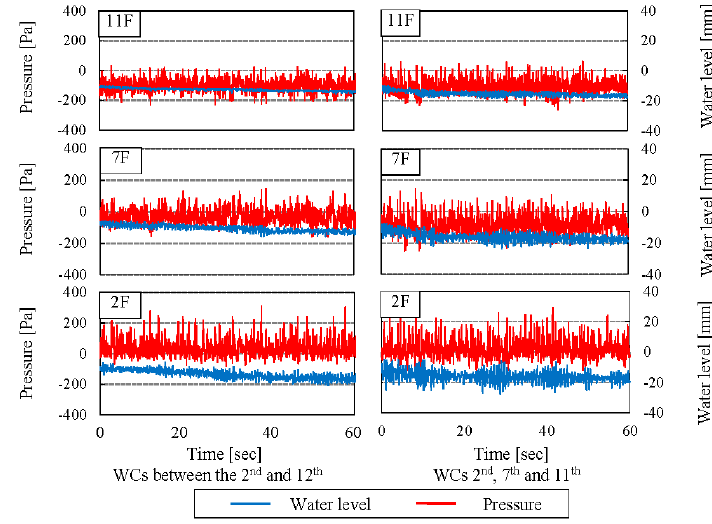
Figure 3. Examples of pressure fluctuation wave patterns and seal water fluctuation wave patterns (4.0 L/s).